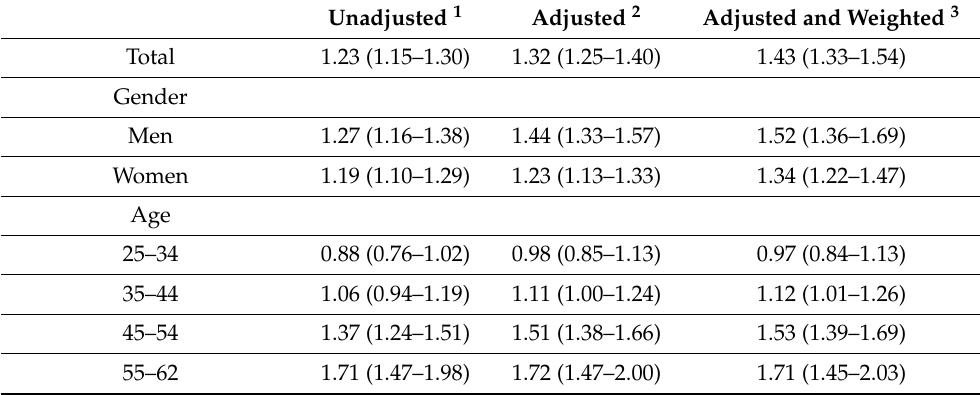
Table 4. Change in the rate of return to work by the study variables, comparing those starting their fixed-term disability pension in 2015 with those who started their fixed-term disability pension in